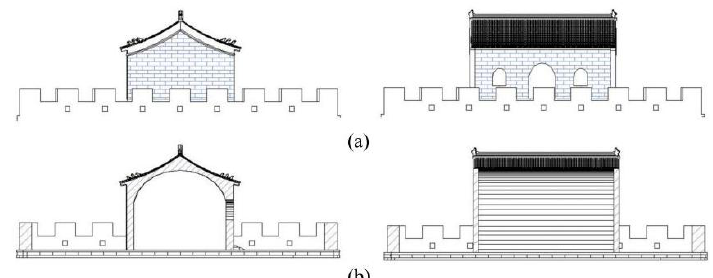
Figure 5. The architectural form and interior space type of the sentry house: ( a ) The facade drawing of sentry house with Flush Gable Roof and gray round tile; ( b ) The cross-section drawing of the tube arch space of sentry house.